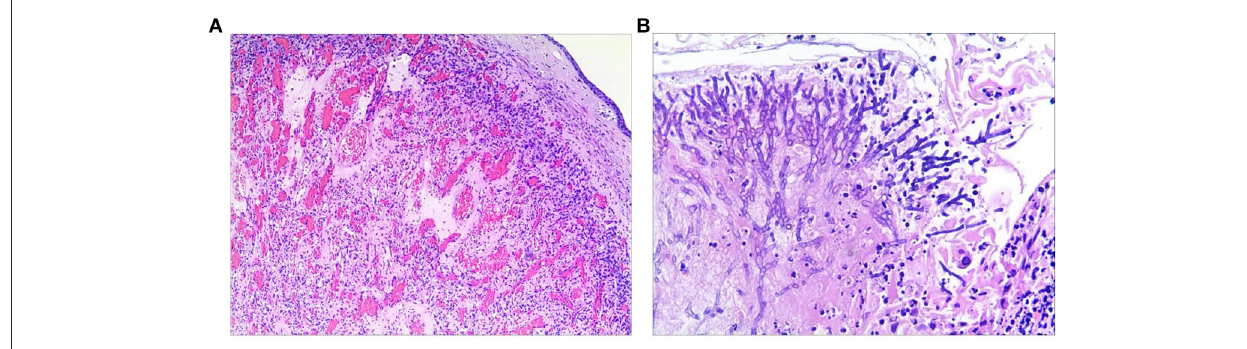
FIGURE3 Histological examination of the resected specimen revealed capillary hemangioma (A) covered by the squamous epithelium and with fungal hyphae inside it (B) .